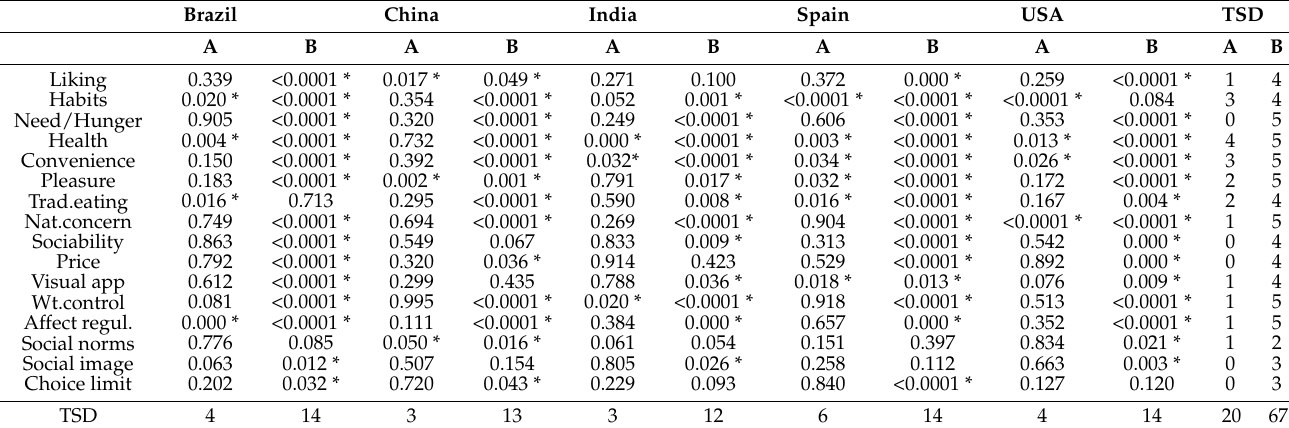
Table 5. p -values of analysis of variance (ANOVA) for food categories or samples for RATA (A) and RATING (B) data for all eating motivation